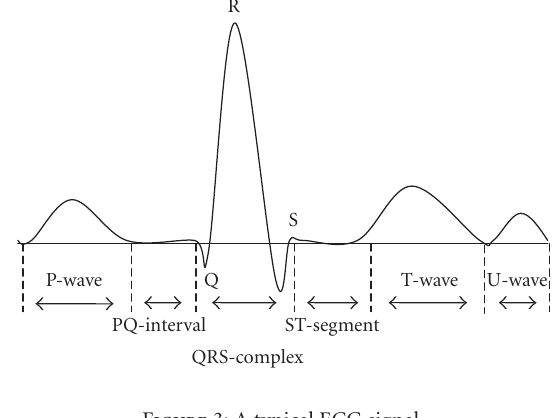
Figure 3: A typical ECG